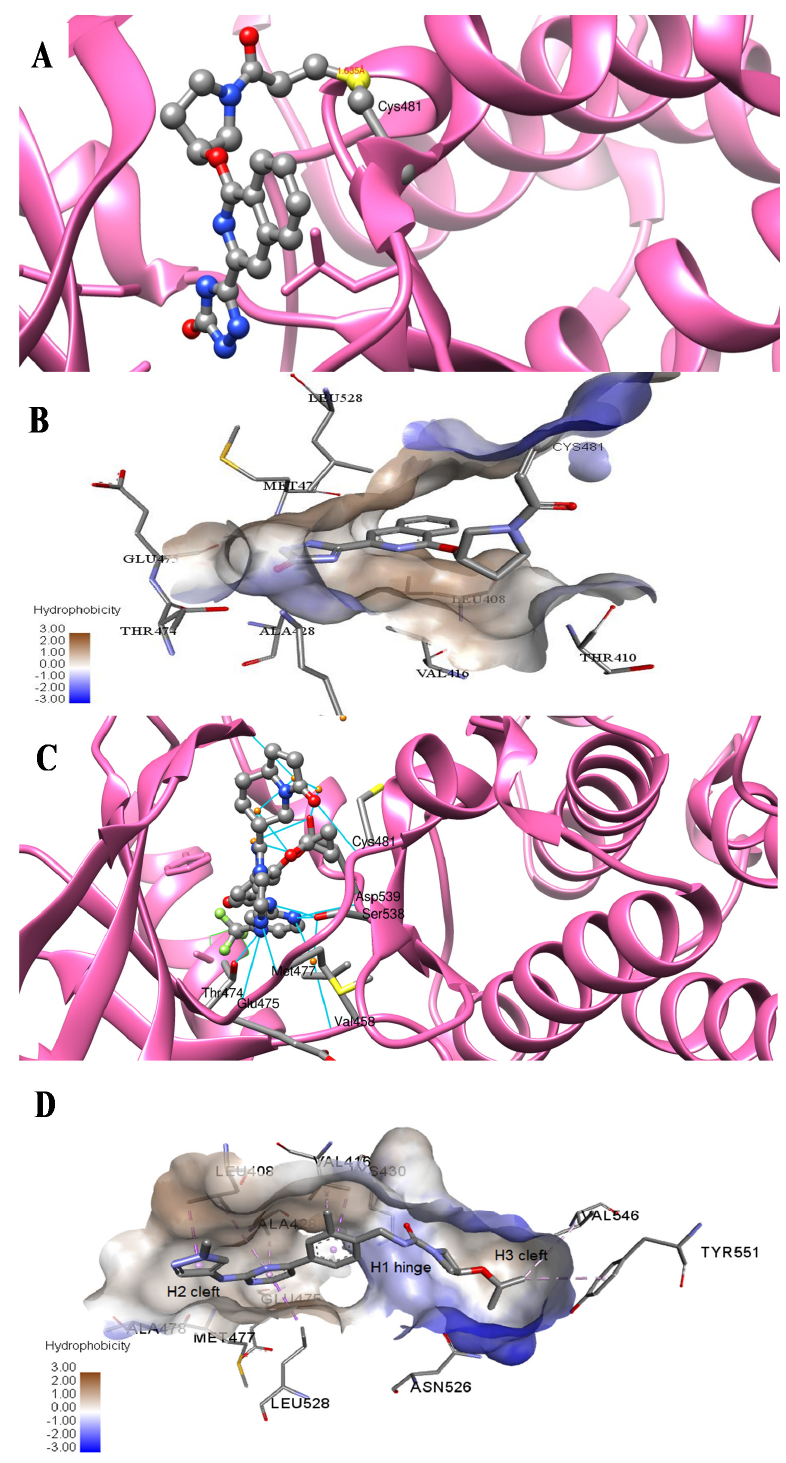
Figure 11. Comparison of binding interactions of covalent and non-covalent inhibitors of BTK-kinase domain. ( A ) TAK-020 interacts through a covalent bond with Cys481 of BTK (7N5Y). ( B ) TAK-020 positioned inside the hydrophobic binding pocket of BTK establishing hydrogen bonds and hy- drophobic interactions. ( C ) BIIB068, a non-covalent inhibitor, establishes hydrogen bonds with the BTK kinase domain (6W07). Cys481 is not involved in interaction with BIIB068. ( D ) BIIB068 engage- ment with Tyr551 creates the H3 hydrophobic cleft for the selectivity of the kinase. Hydrophobic interactions with nearby residues of H1 and H2 sites are also